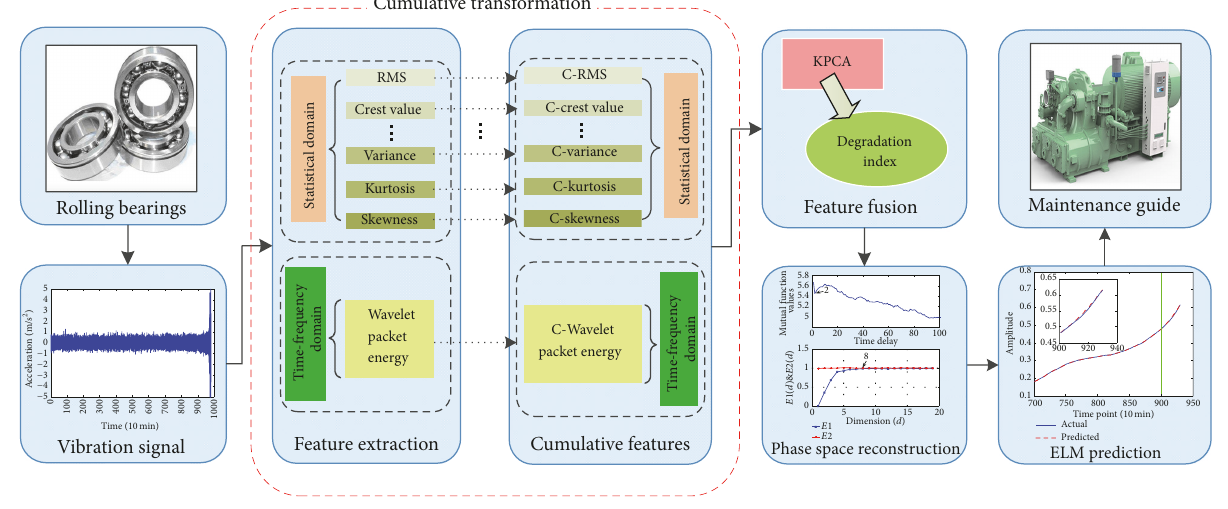
Figure 2: Flowchart for bearing degradation trend